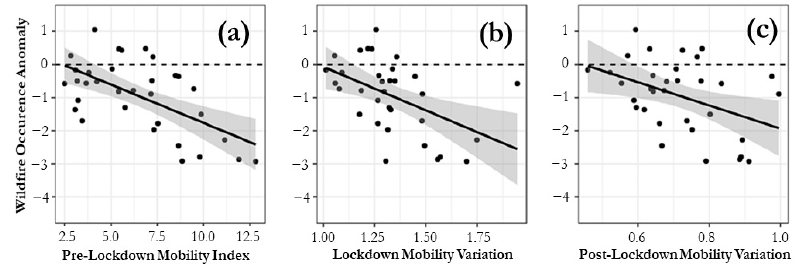
Figure 5. Linear adjustment of the fire occurrence anomaly for the selected communes and each of the mobility variables: Mob1, Mob2 and Mob3.